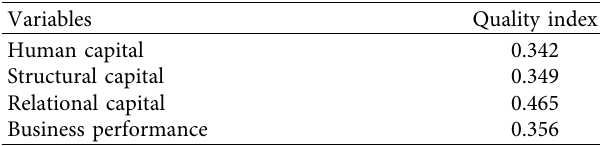
Table 4: A quality test of the measurement model.